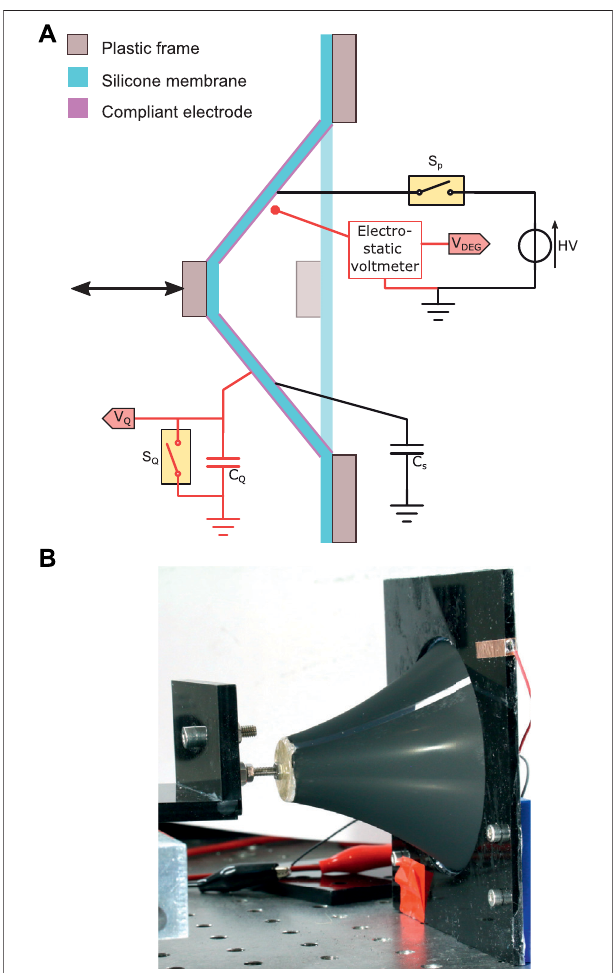
FIGURE 8 | (A) schematic representation of the conical DEG under test. The parts in red are components used to characterised the behaviour of the DEG,butwhicharenotrequiredfornormaloperation. (B) pictureofthedevice under test with an out-of-plane displacement of the central hub of 60 mm.